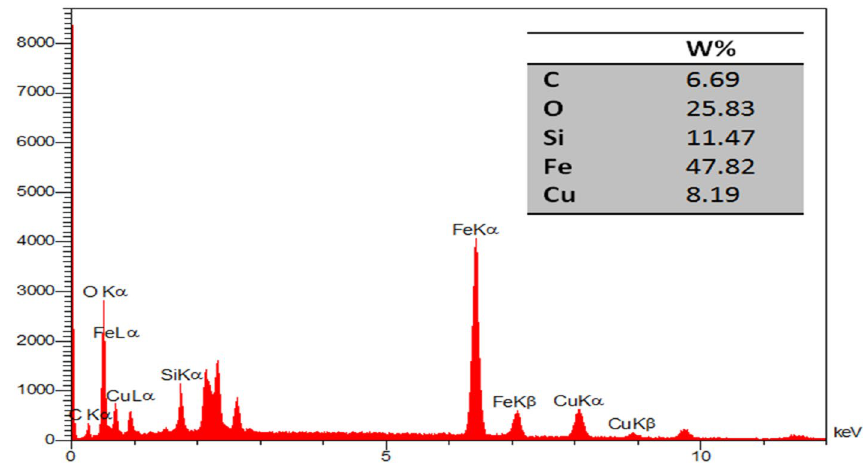
Figure 7. EDX results of the Fe 3 O 4 @Glycerol-Cu nanocatalyst.